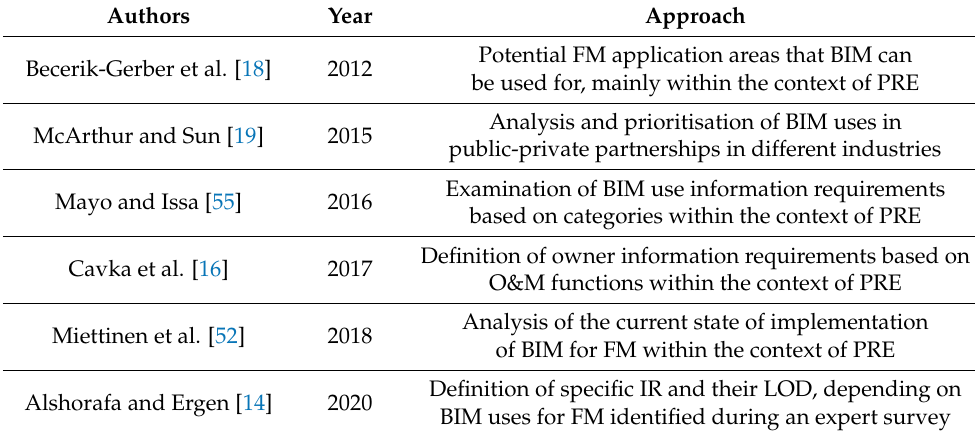
Table 1. Related studies investigating BIM uses for FM.